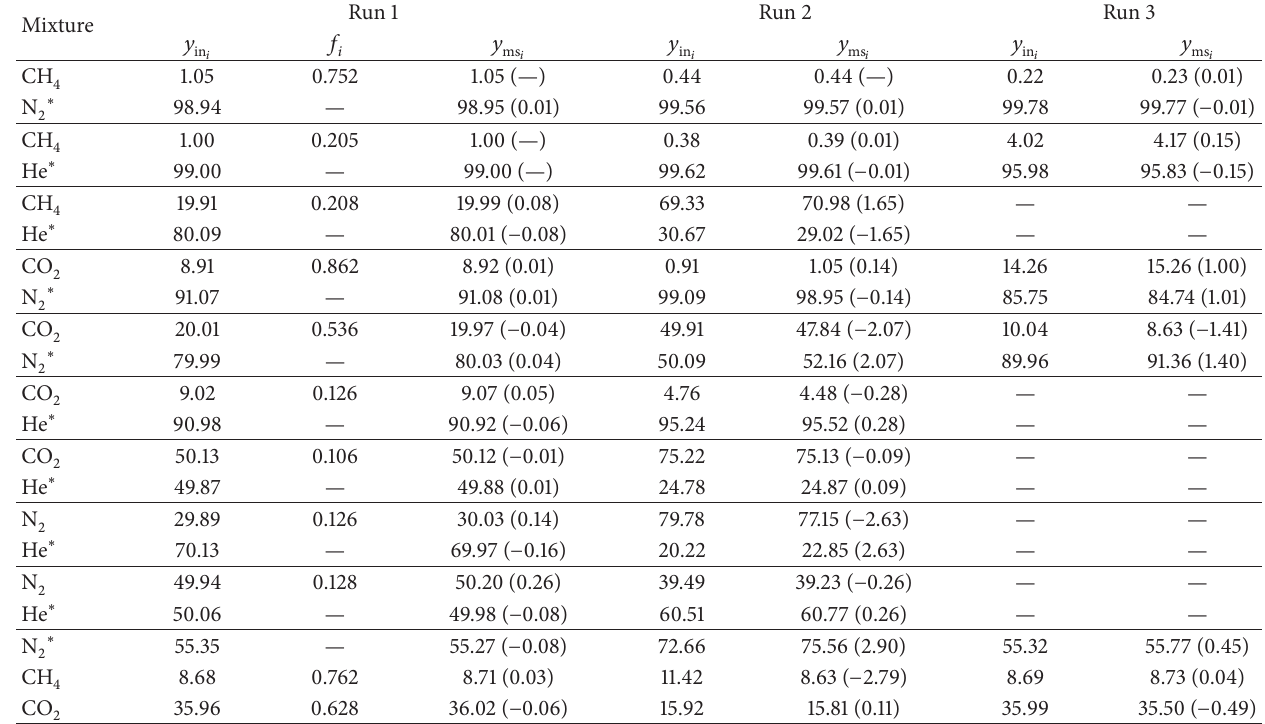
Table 2: Illustrative data results obtained for the single-point calibration procedure of the sampling gas mixtures used experimentally. Run 1 reports the single point calibration experiment, while runs 2 and 3 denote the respective tuning